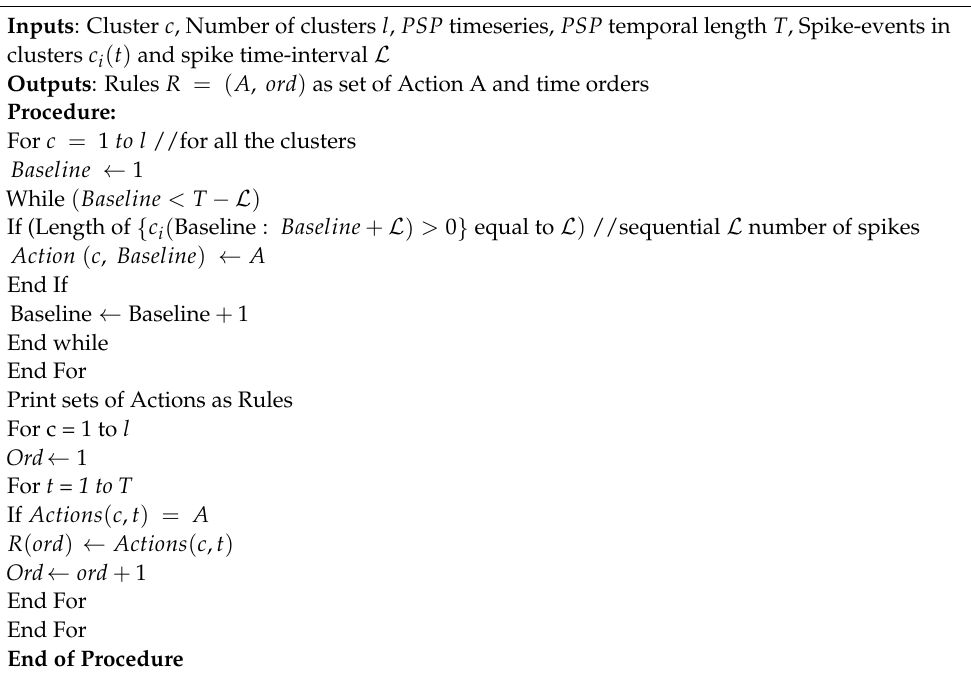
Algorithm 2. Defining the order of the time interval when spike actions A are